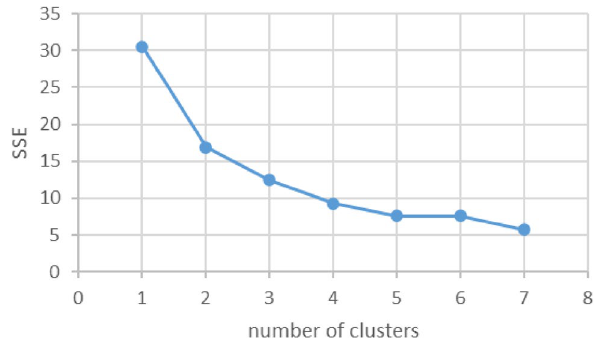
Fig. 7 FZI logarithm histogram